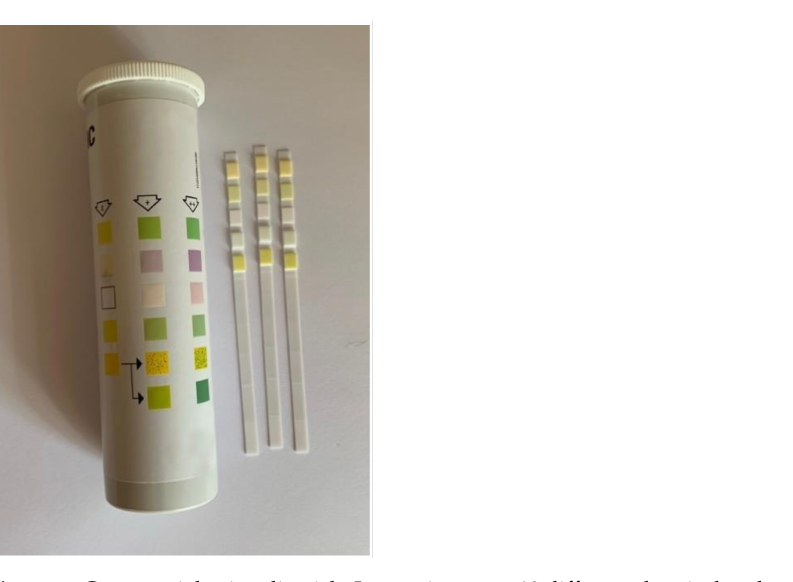
Figure 3. Commercial urine dipstick. It contains up to 10 different chemical pads which change color when it is immersed in and then removed from a urine sample, allowing semi-quantitative analysis of analytes such as glucose, ketones, bilirubin and